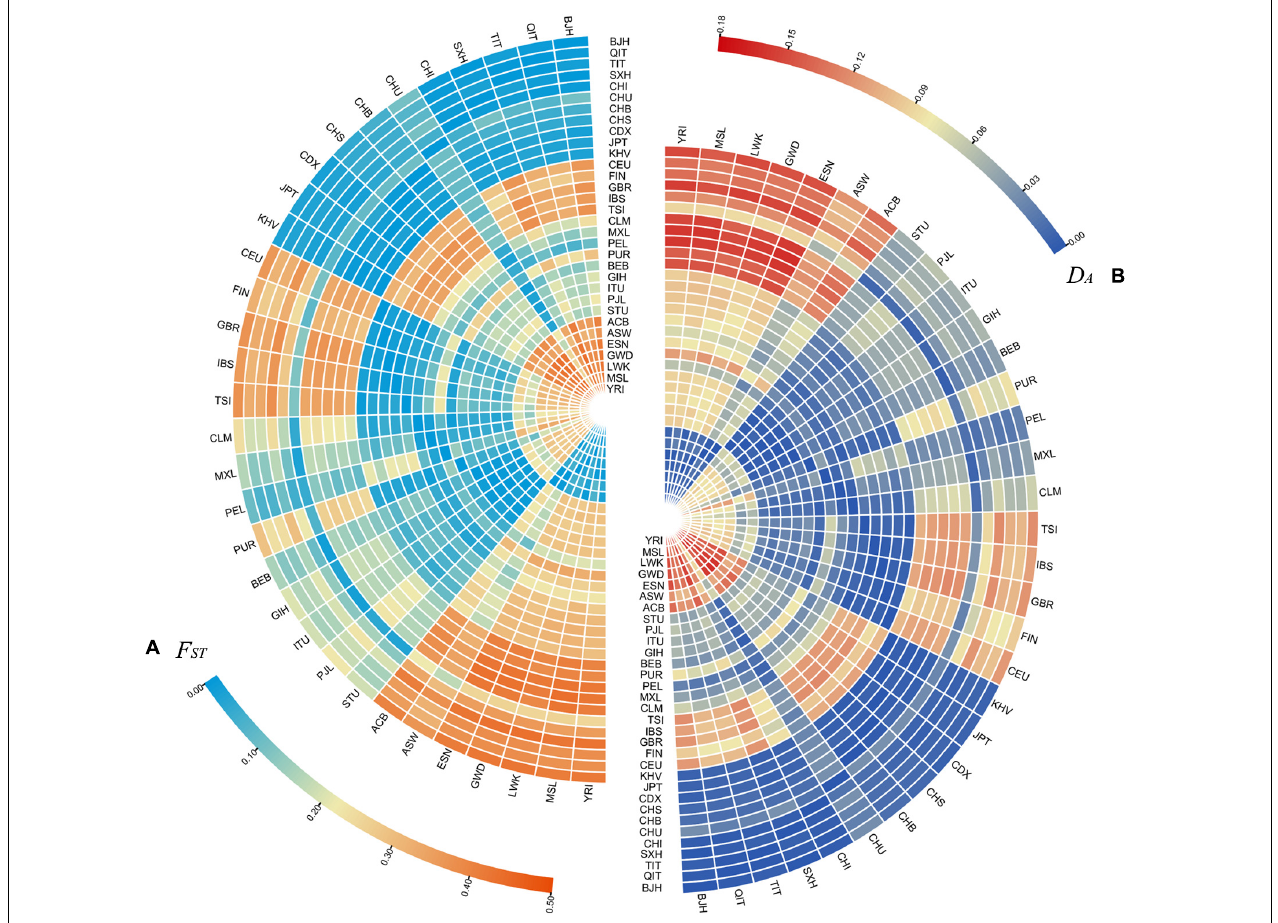
FIGURE 3 | The heat maps of the pairwise F ST values (A) and D A distances (B) among the Beijing Han populations and 31 reference